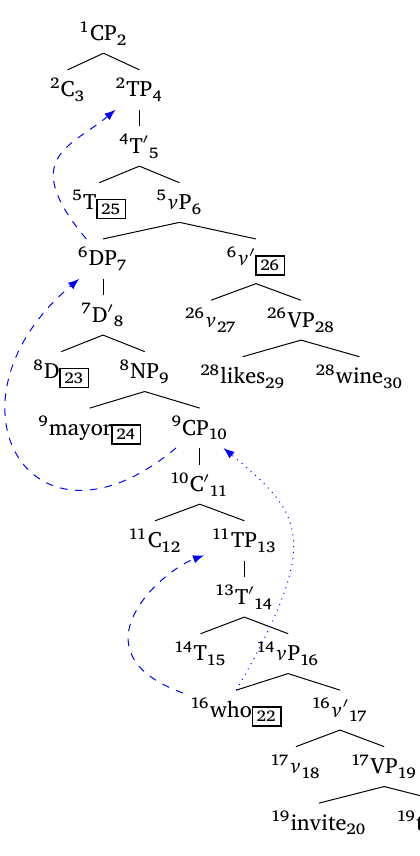
Figure 12: SRC in Chinese, wh-movement